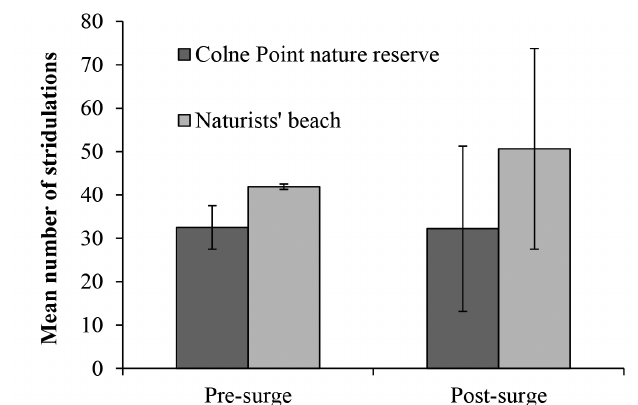
Fig. 3. The mean number of stridulating males recorded on the Colne Point nature reserve and St. Osyth naturists’ beach pre- and post-surge.